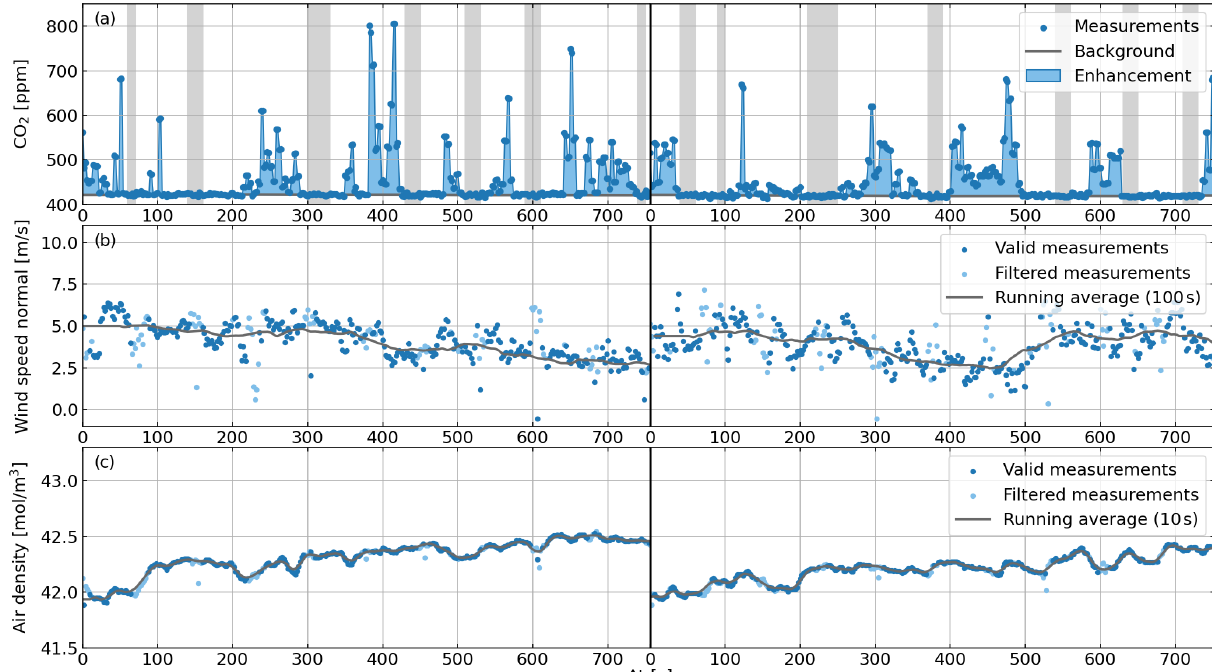
Figure 8. Measurements and results from two flights downwind of the ExxonMobil natural gas processing facility in Großenkneten 40km west of Bremen, Germany, 10 April 2020. (a) CO 2 mole fraction as well as background values (gray line) estimated from measurements within light gray areas and CO 2 enhancement (light blue area). (b) Wind speed normal including 100s running average (gray line), filtered measurements with UAV accelerations larger than 0.1ms − 2 (light blue), and valid measurements (bold blue) used to compute the running average. (c) Air density including a 10s running average and filtering information (light and bold blue) as for the wind speed normal. Left: flight 1. Right: flight 2.